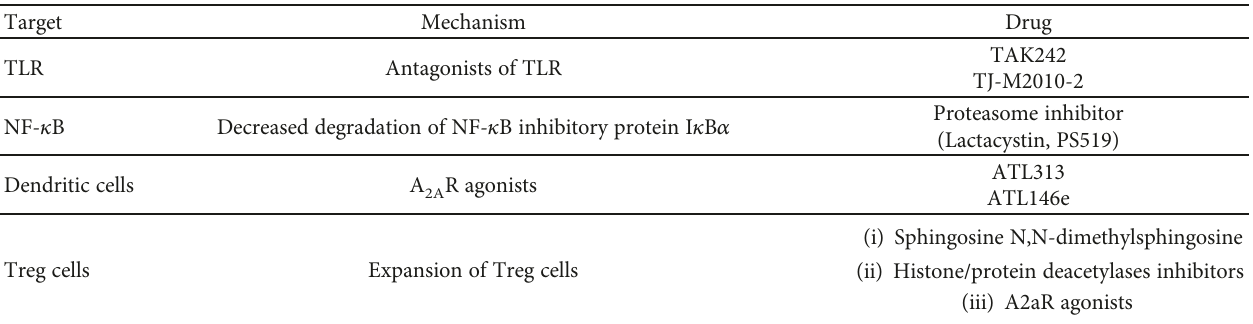
Table 1: Potential pharmacological approaches targeting immunological mechanisms in ischemia/reperfusion injury.